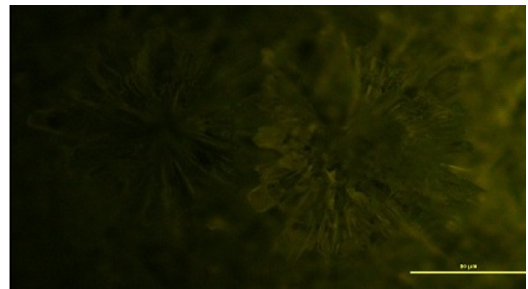
Figure 7. Epifluorescence image of MMTG crystal